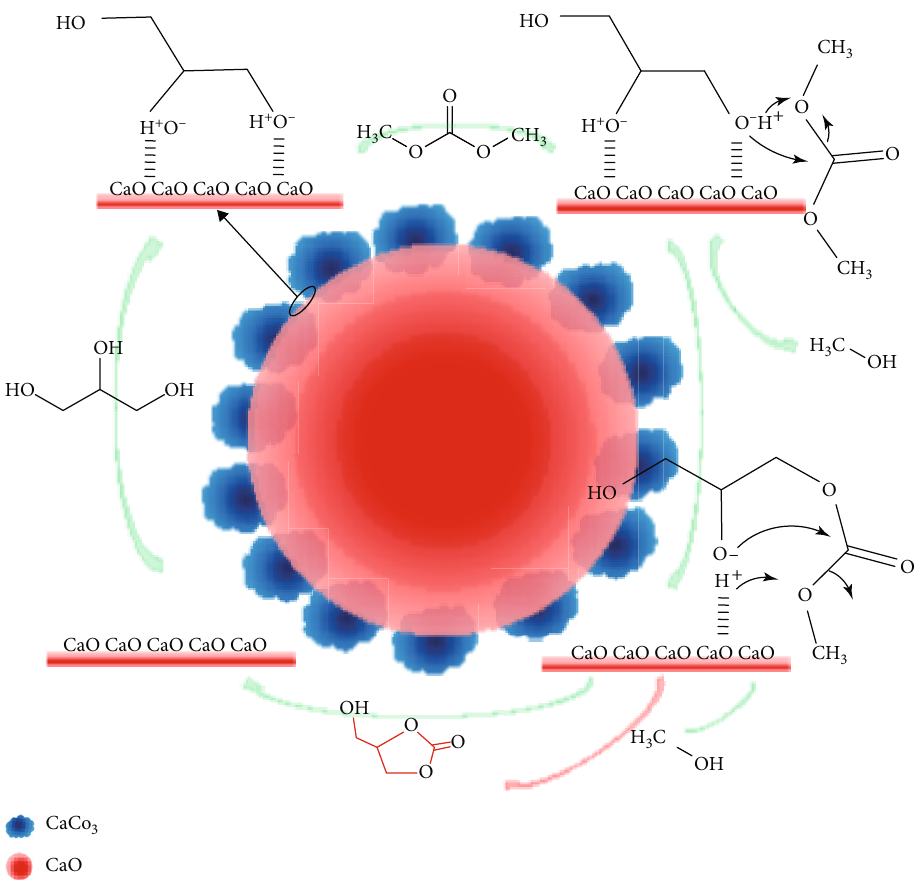
Figure 14: Proposed mechanism for the 15 wt.% Na